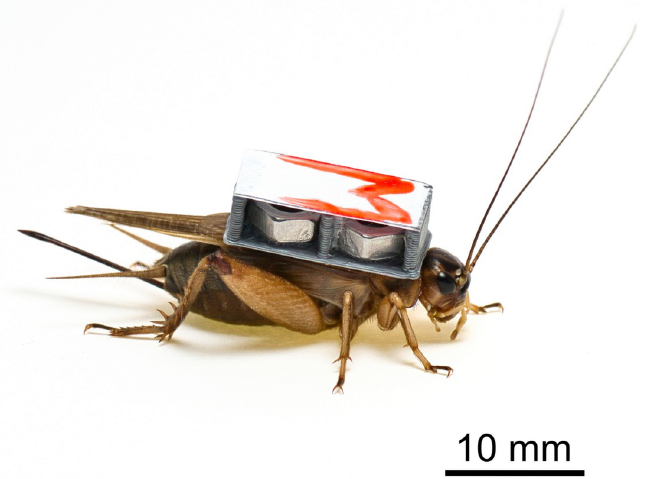
Fig 2. Attachment of the heavy dummy transmitter with a unique UV paper label on a Gryllus locorojo female. Only UV paper labels were attached to control crickets.